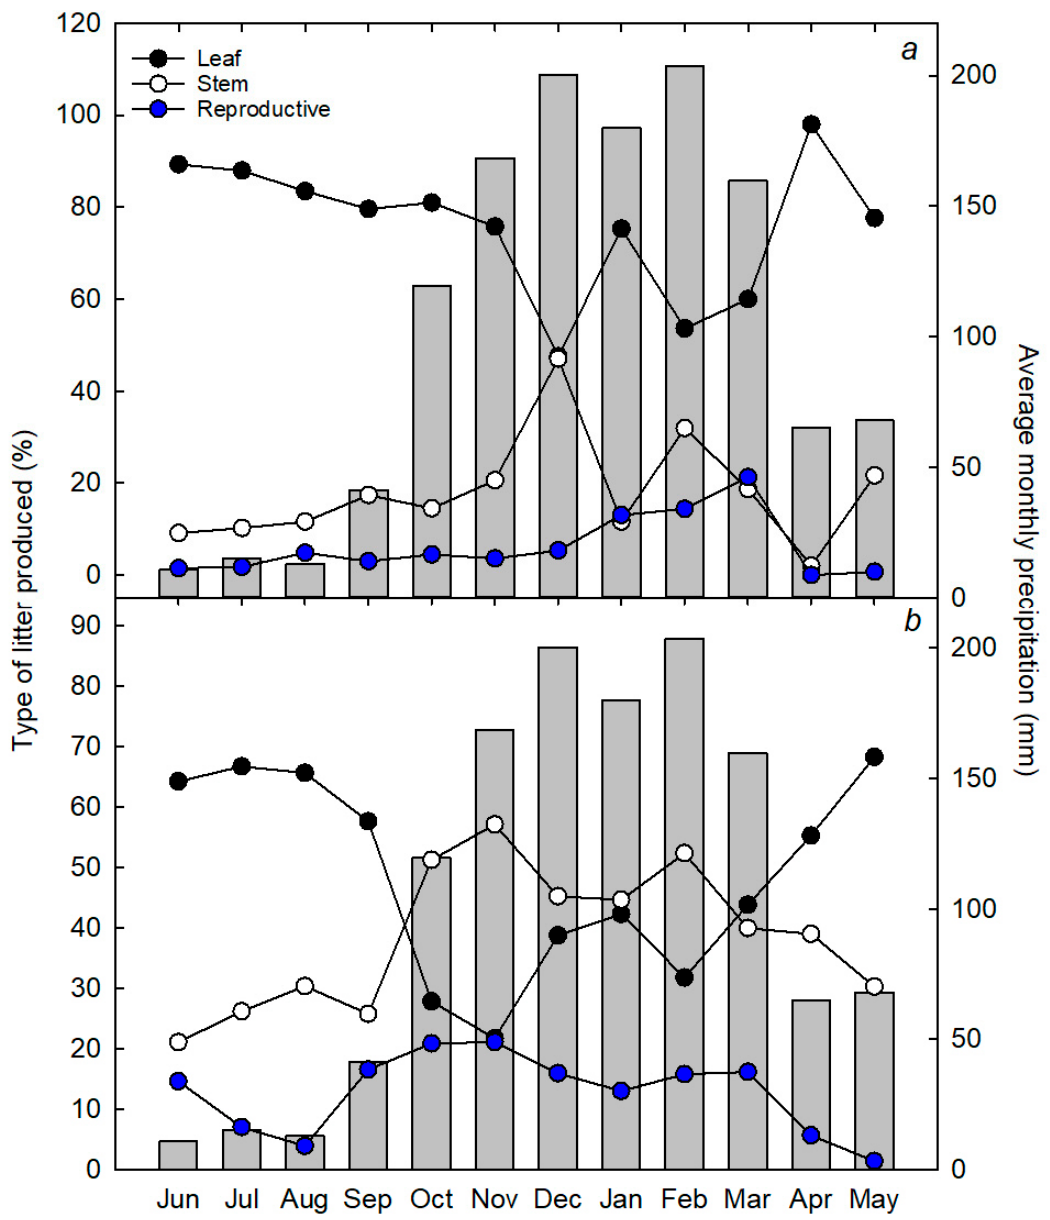
Figure 2. Mean monthly proportion of leaf (black symbols), stem (white symbols), and reproductive material (blue symbols) relative to the total litter produced for the seasonally flooded cerrado forest ( a ) and the upland mixed forest ( b ) during the 2014–19 study period. The solid bars in both panels are the average monthly rainfall for the same period.